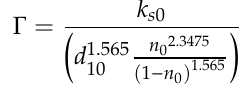
Table 1. Details of parameter calibration.